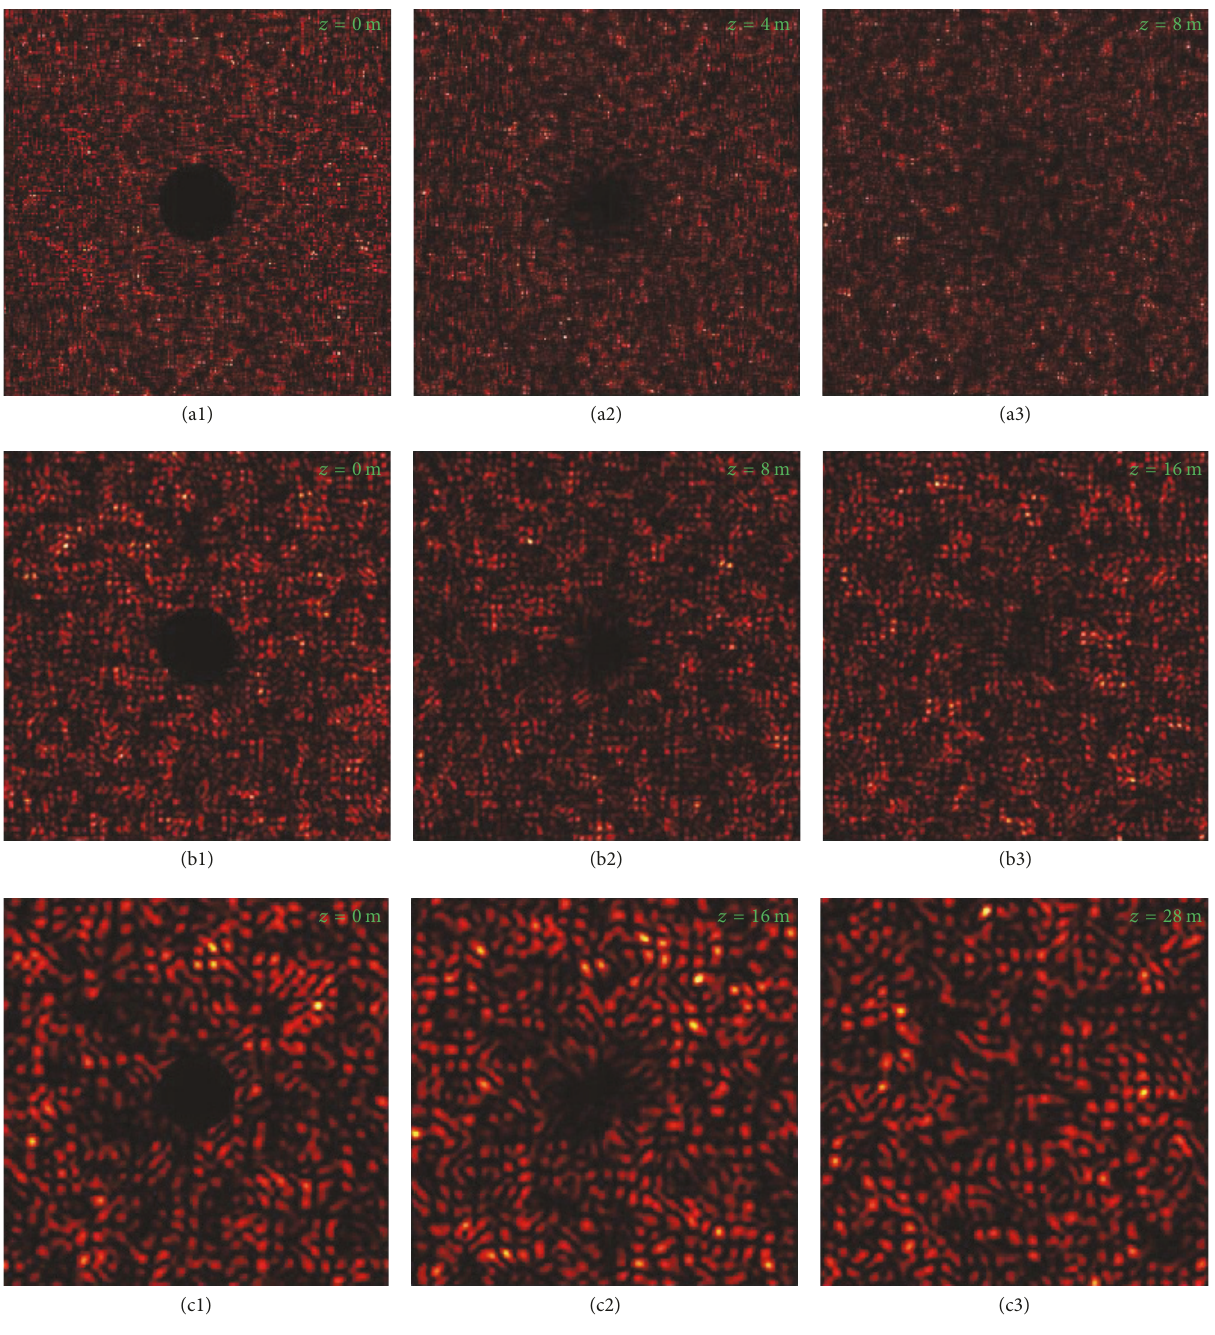
Figure 6: The simulation of speckle pattern at different propagating distance for different coherence length with 𝑅 = 5 mm, 𝑛 = 1 . The first row 𝛿 = 3 mm, the second row 𝛿 = 6 mm, and the third row 𝛿 = 12